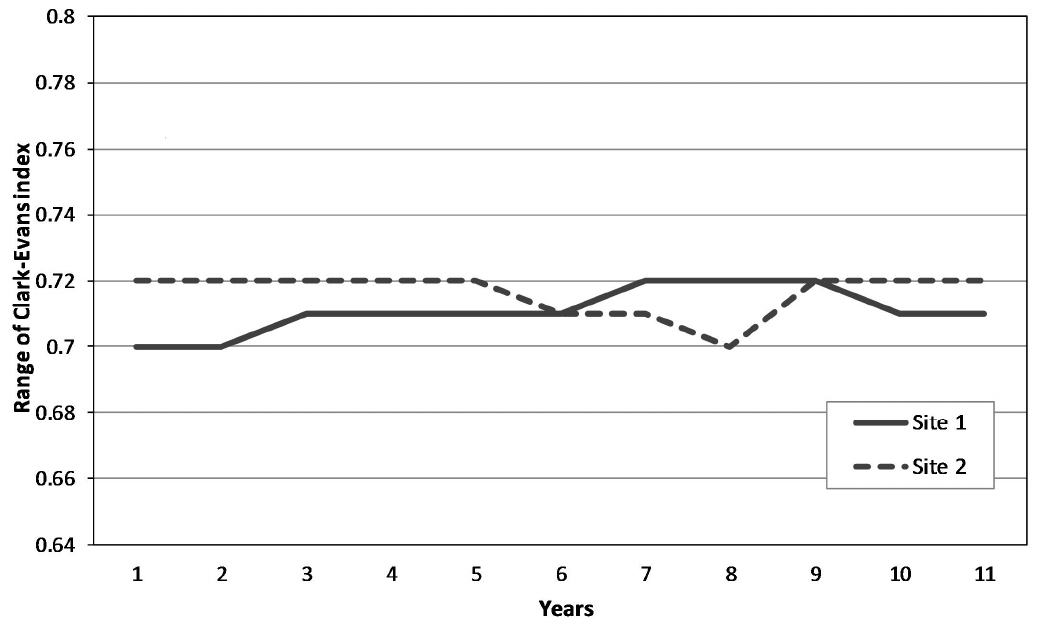
Figure 7. Prediction of the Clark-Evans aggregation index values for both study sites.